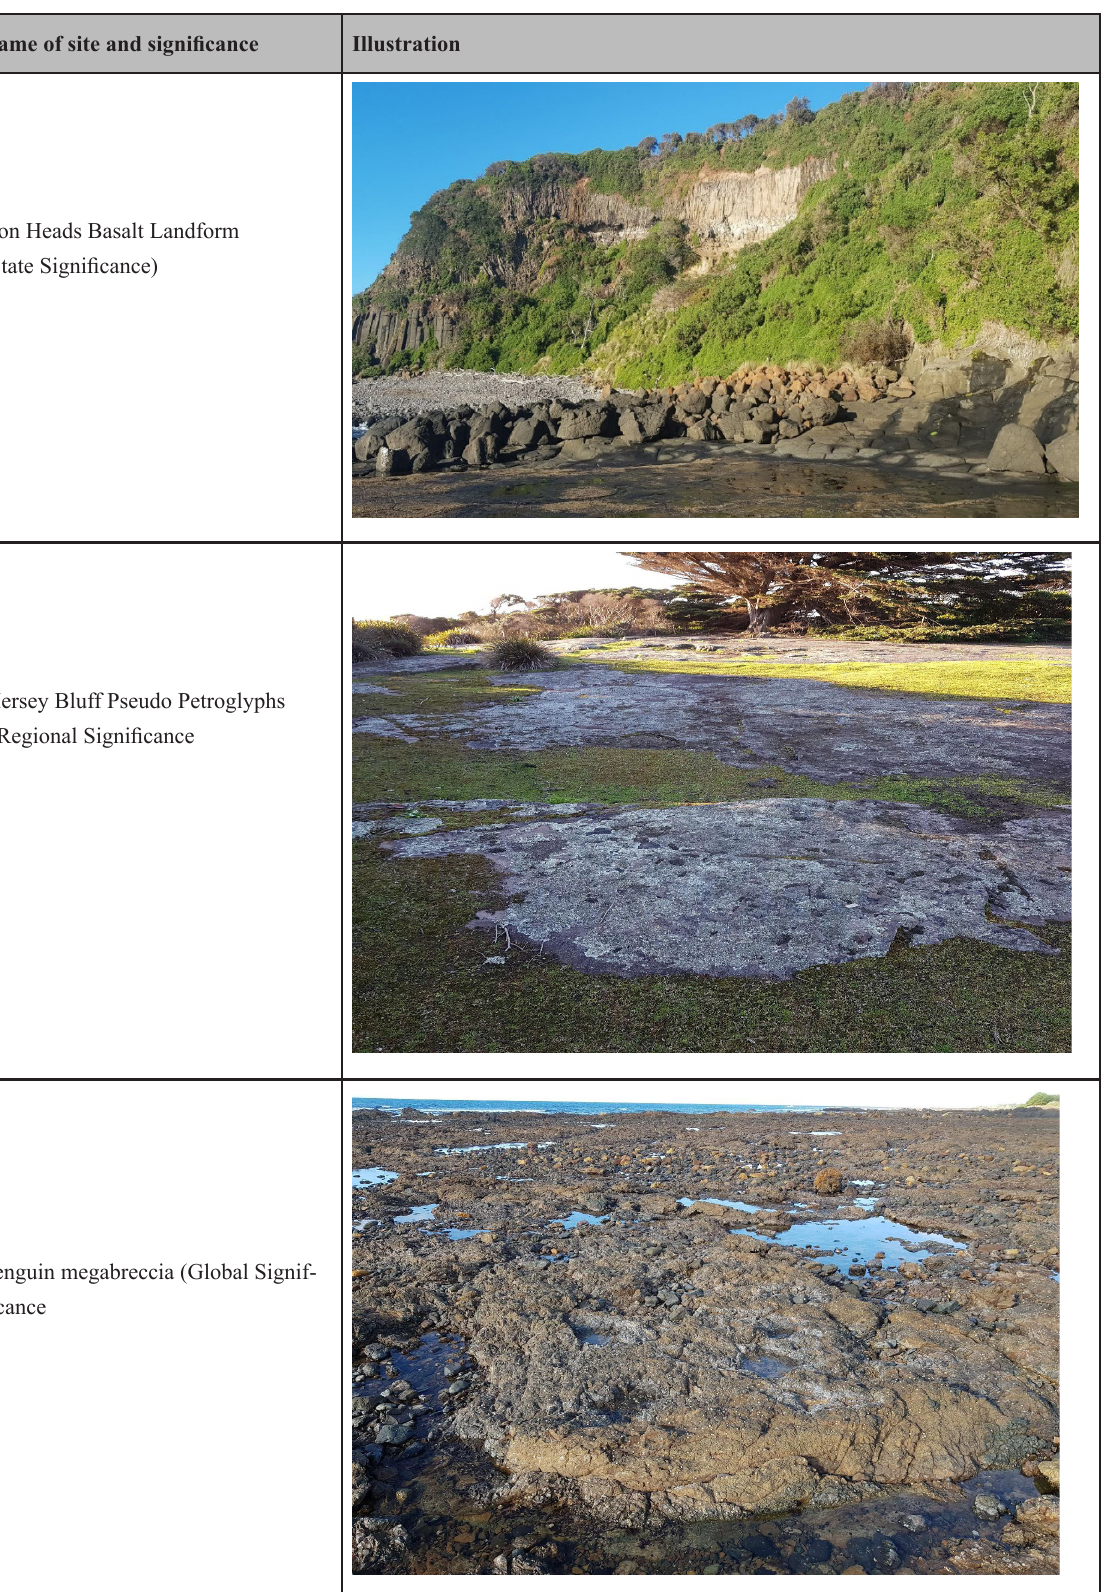
Table 3. Photographs of three coastal study sites from each site